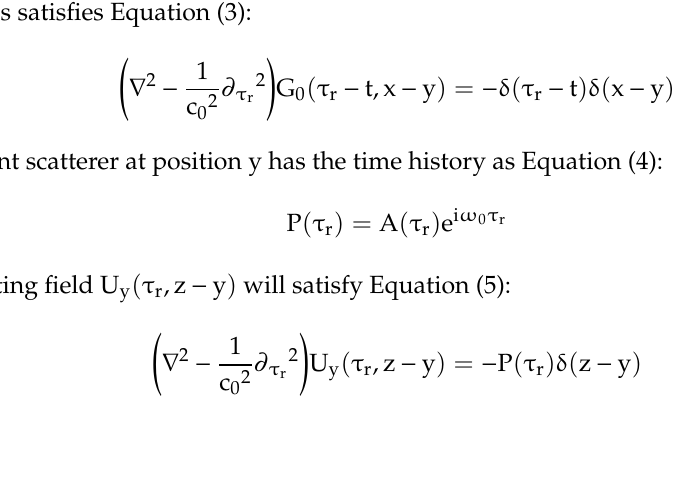
Figure 1. Geometry of the illumination from the antenna toward the CTT.